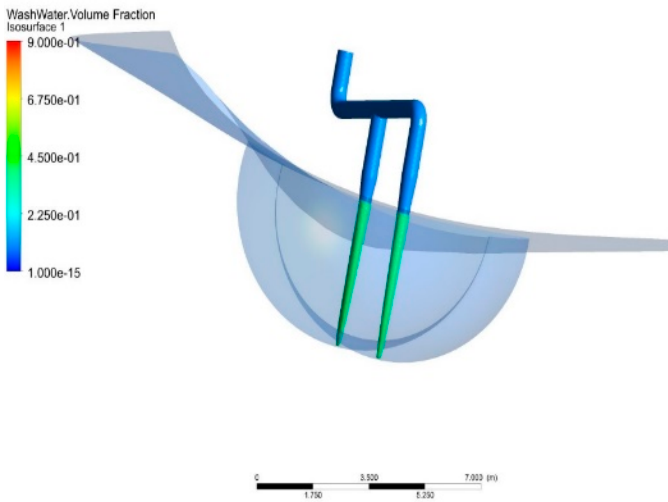
Figure 17. Scrubber Wash Water Volume Fraction of 0.41 isosurface development.